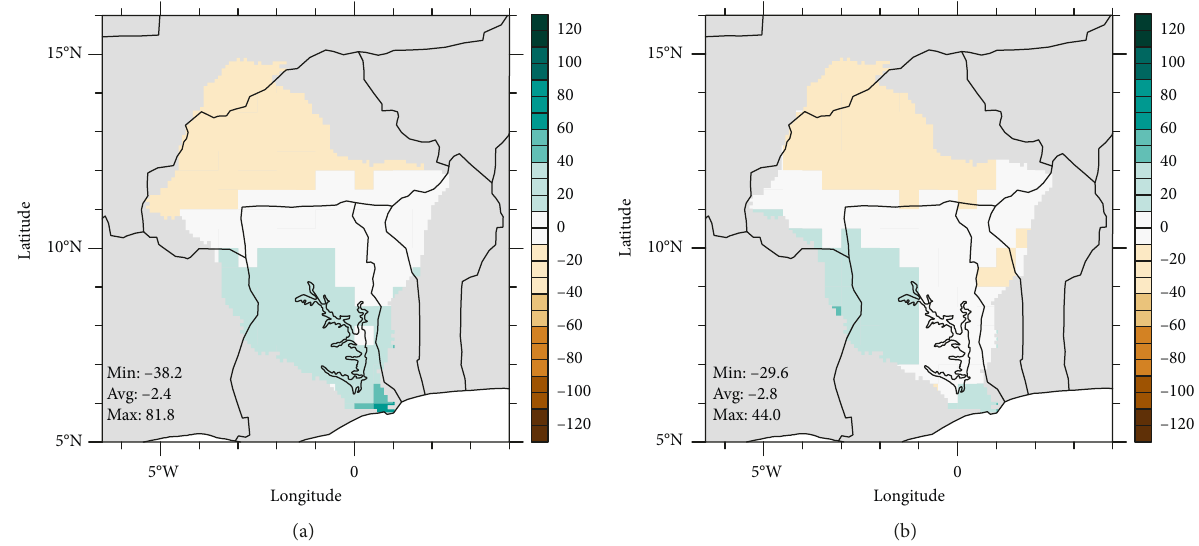
Figure 4: The climatological (1950–2004) mean bias in the annual total precipitation of BCC-CSM1.1 (a) and BNU-ESM (b). They averagely underestimate the observed